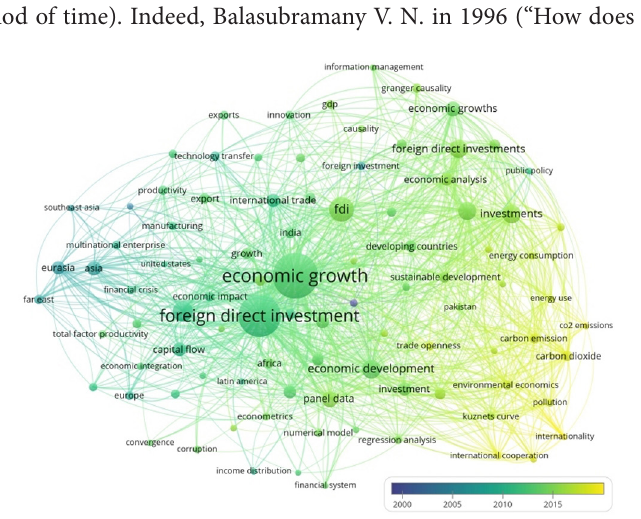
Figure 5. Evolution of keywords over time (source: Scopus, using